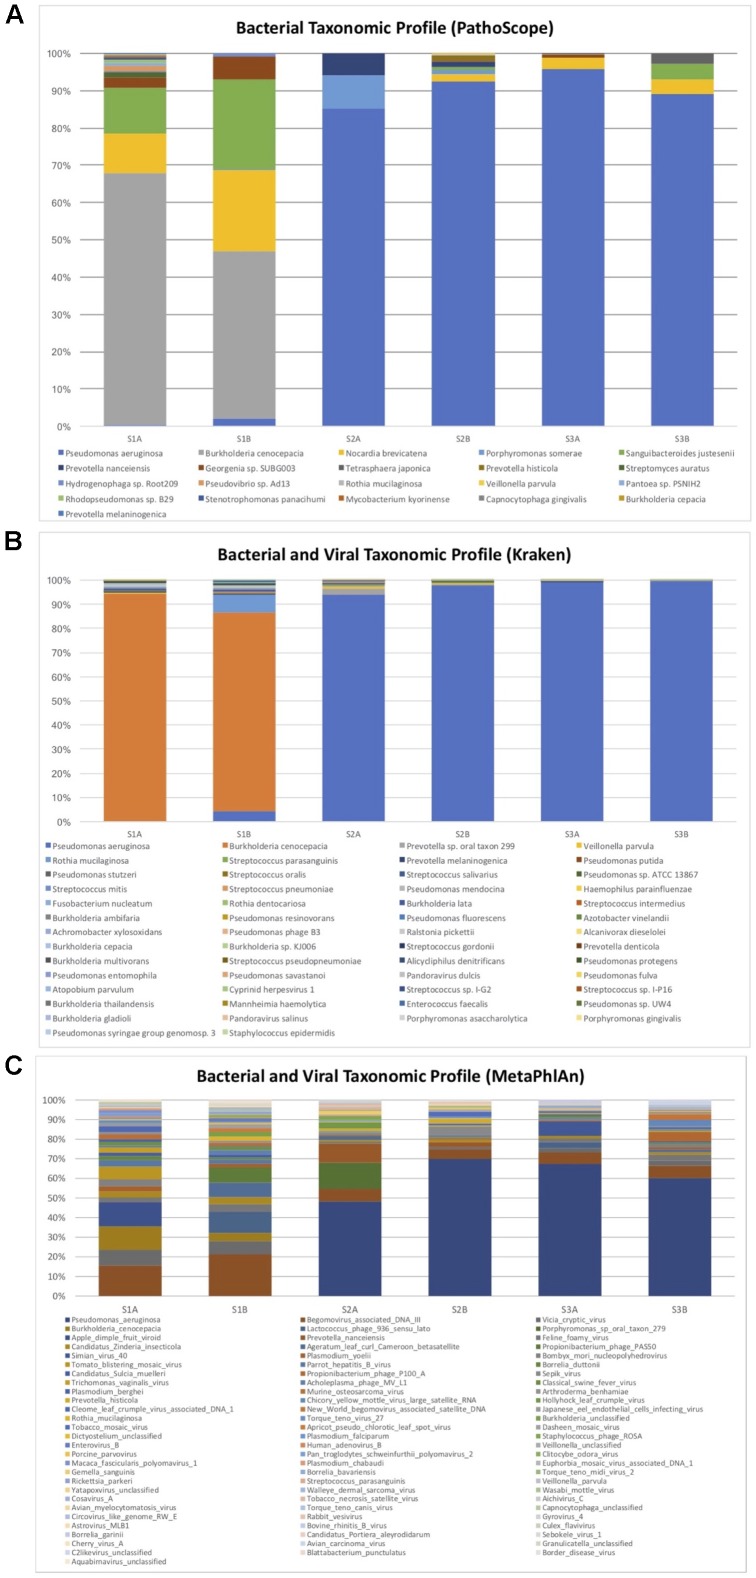
Bacterial and viral taxonomic profile of pre- and post-antibiotic sputum samples in three subjects with cystic fibrosis who grew antibiotic resistant bacteria. Only bacterial and viral species with a minimum total observation count of 0.01% of total reads are shown for PathoScope (A) and Kraken (B). Only bacterial and viral species with a minimum total observation count of 0.1% of total reads are shown for MetaPhlAn (C). Burkholderia cepacia was the pathogen identified in culture for subject S1, but the majority of reads were attributed to Burkholderia cenocepacia. Pseudomonas aeruginosa was identified as the predominant bacteria for subjects S2 and S3, and was also identified in corresponding respiratory cultures.